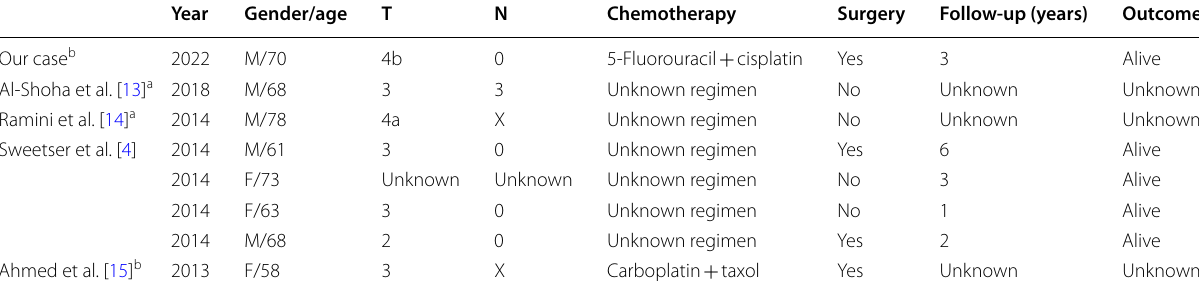
Table 1 Literature review of seven cases, including our case, of verrucous carcinoma of the esophagus treated with chemoradiation